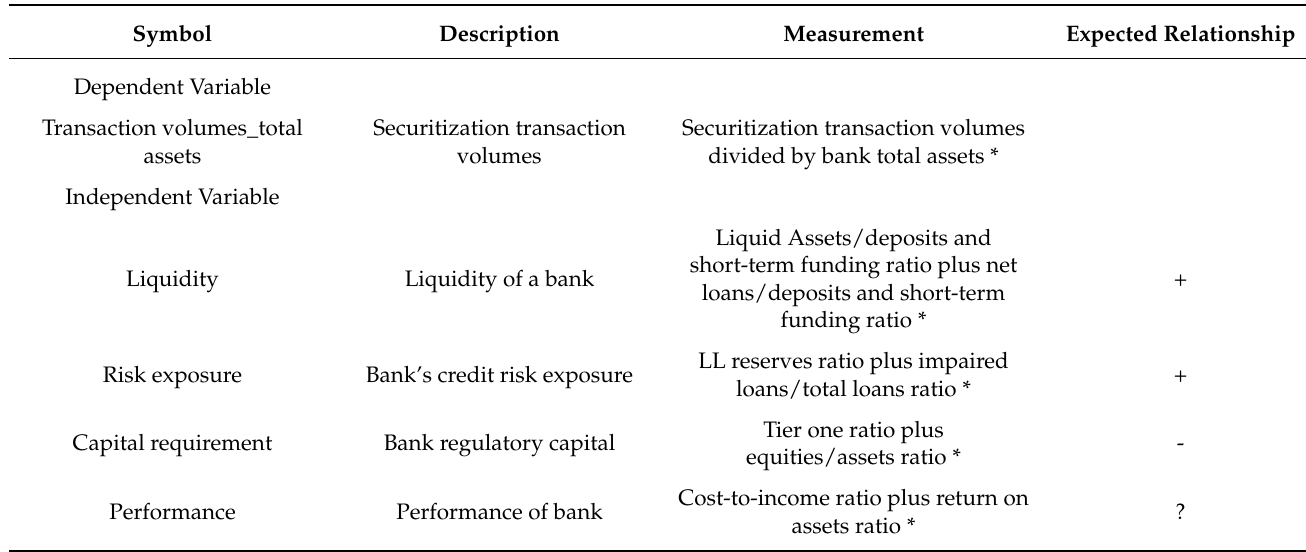
Table 1. Variable definitions and expected